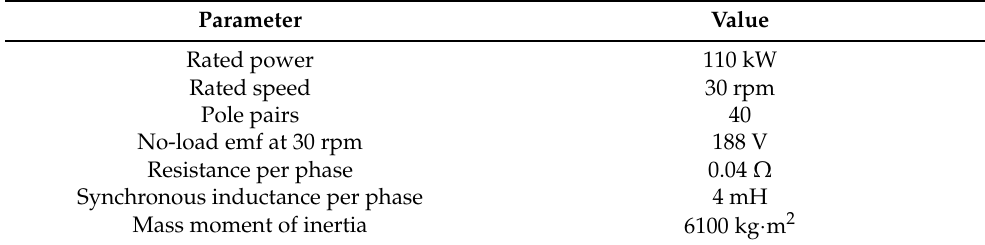
Table 2. Generator parameters.